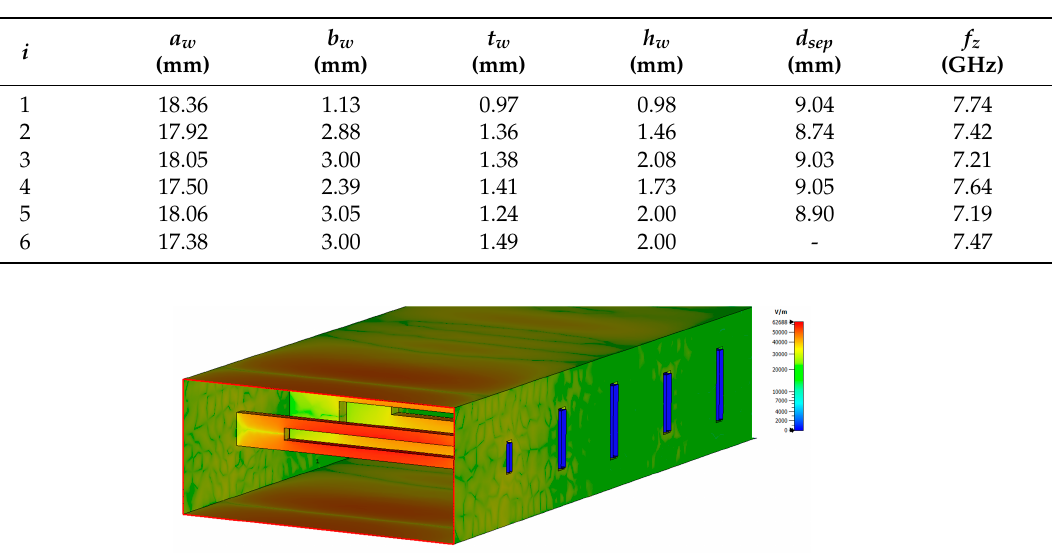
Figure 10. Simulated results of the maximum E-field in the Tx filter at 7.75 GHz. Maximum value of 62.688 V/m is obtained at the first iris.